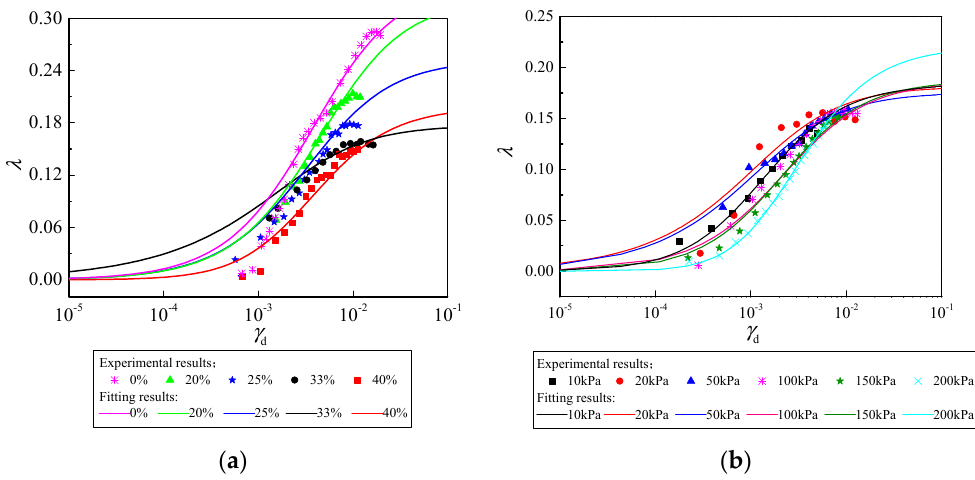
Figure 11. Damping ratio versus the shear strain amplitude for various sawdust contents and confining pressures. ( a ) Damping ratio versus shear strain amplitude for the various sawdust content. ( b ) Damping ratio versus shear strain amplitude the various confining pressure.